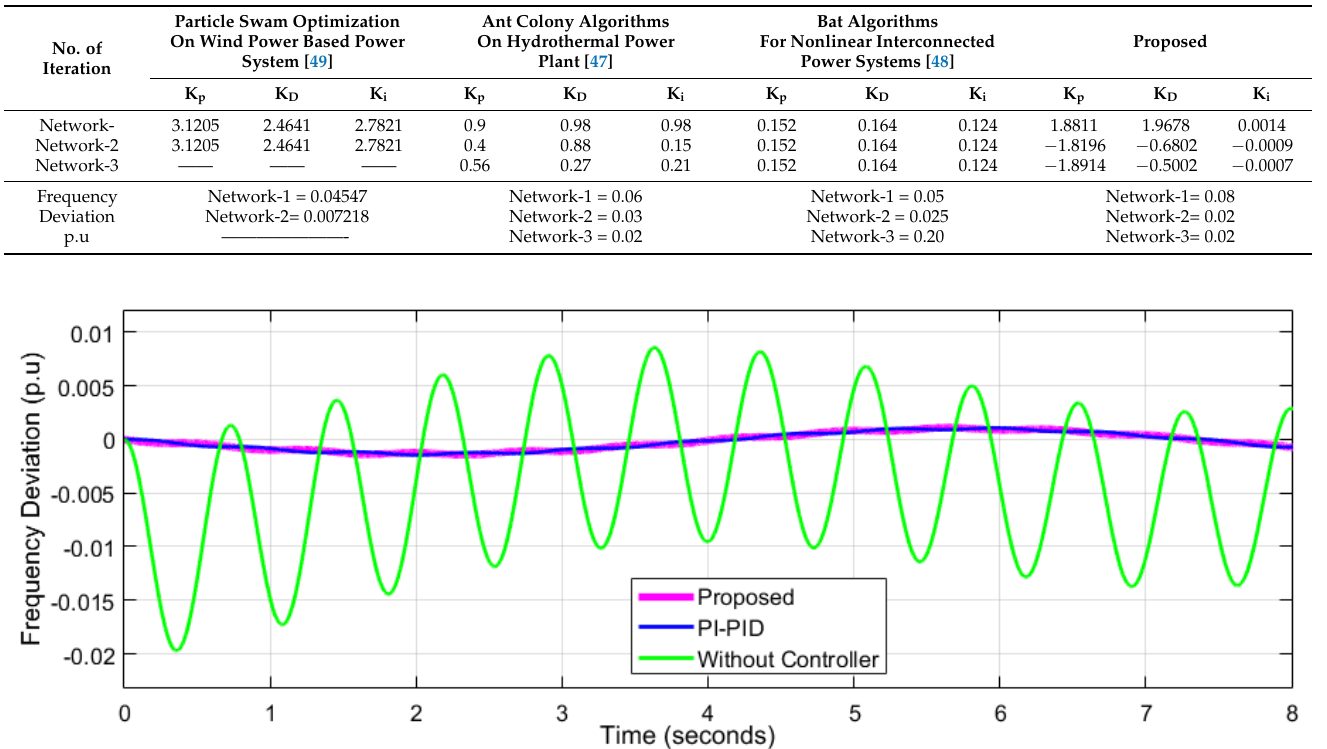
Table 8. Comparison of Proposed Algorithms with PSO, Ant Colony, and Bat Alogorithms.